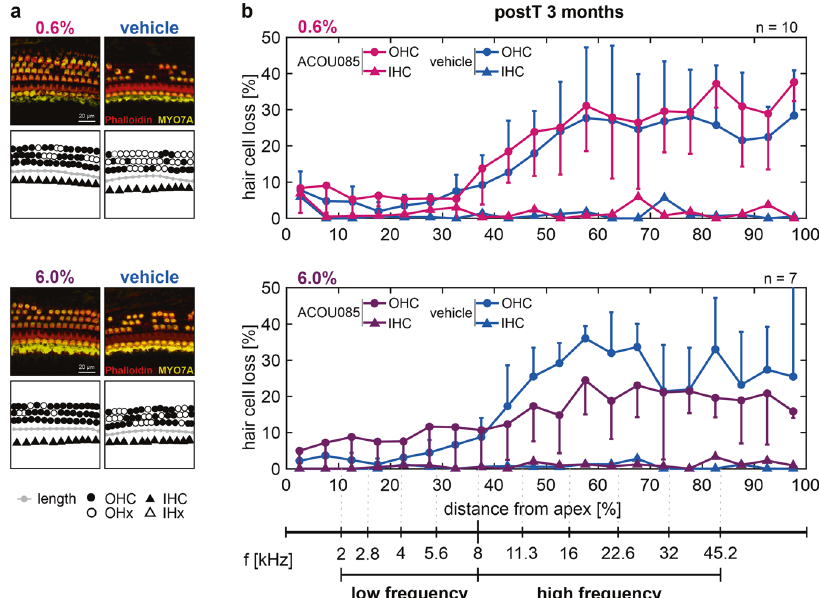
Fig. 4 Quanti fi cation of outer and inner hair cell loss in SAMP8 mice treated with ACOU085 and vehicle control. The effect of repeated unilateral administrations via transtympanic injection of ACOU085 versus contralateral vehicle control was investigated in the SAMP8 mouse model in a within-subject design. After the last follow-up measurement at 3-months post-treatment (postT, age of 135 days, see Fig. 1b), cochleae were extracted for immunohistochemical analysis to determine the degree of outer and inner hair cell (OHC and IHC, respectively) loss for either 0.6% or 6.0% w/v ACOU085 and corresponding vehicle control. a Illustrative examples are shown for cochlear segments (scale bar, 20 µm) stained with myosin VIIa (MYO7A, yellow) for cytoplasm and phalloidin (red) for stereocilia of SAMP8 mice treated with either 0.6% or 6.0% w/v ACOU085 and vehicle control. b Cytocochleograms show mean and standard error of the mean OHC and IHC loss in percent, respectively, which are calculated as the ratio of absent hair cells to the sum of present and absent hair cells within 5% bins of distance from apex, for the 0.6% ( n = 10) or the 6.0% group ( n = 7, due to 1 exclusion at 3-months postT). A mouse place-frequency map [39, 40, 55] was then used to divide the cytocochleograms into low- ( ≤ 8 kHz) and high-frequency (>8 kHz) ranges. For reference, a frequency ( f ) axis is depicted with respect to the relative distance from